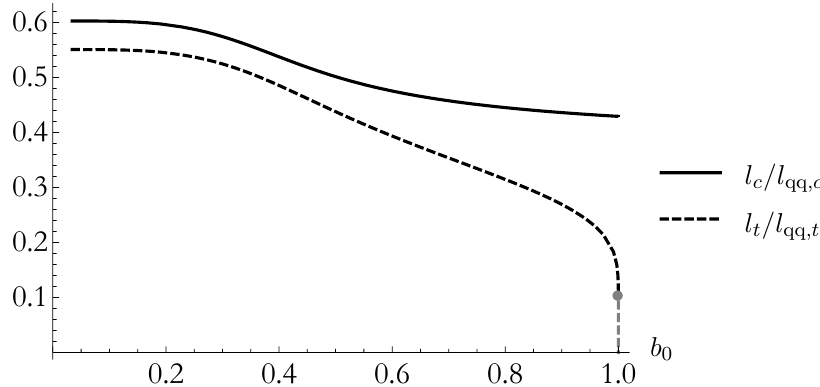
Figure 13. Ratios between scales stemming from quark-antiquark potentials and entanglement entropy of strips as a function of b . The solid curve is the ratio between the critical lengths 0 where the disconnected strings and t -RT-surface become dominant for the Wilson loop and for entanglement entropy of a strip, respectively. The dashed curve stands for the ratio between the turning points of hanging string configurations and the RT embeddings. The last part of this curve, drawn fainter and below the gray dot, stands for